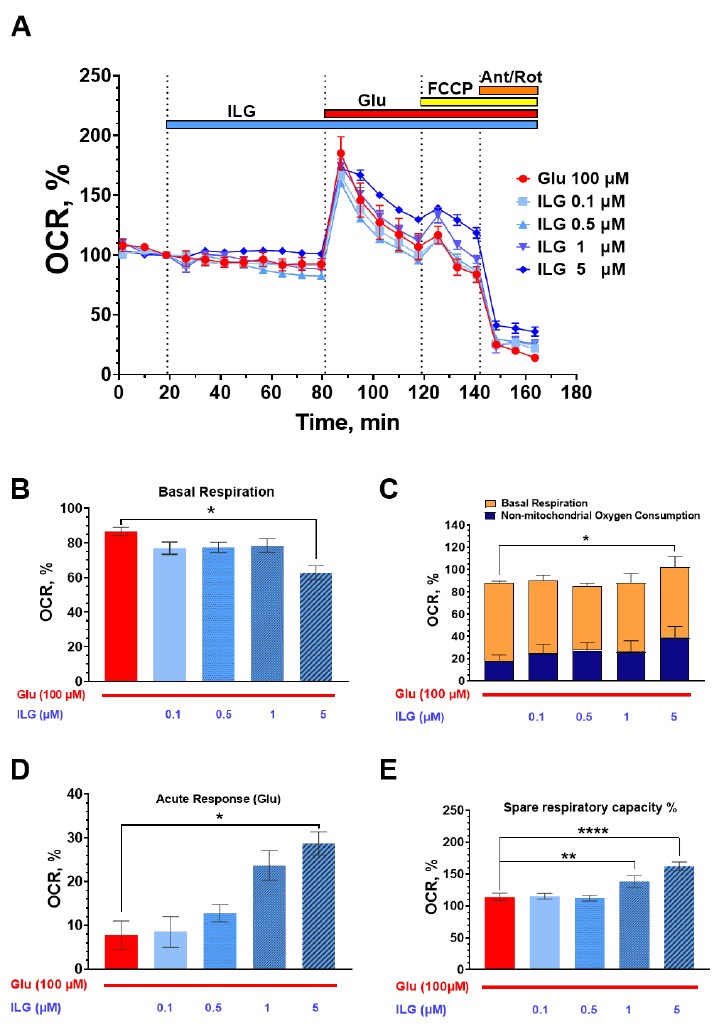
Figure 4. Effect of glutamate and ILG on the oxygen consumption rate (OCR) in primary neuroglial culture. ( A ) Cumulative curve of the effect of glutamate on OCR in the presence of ILG; ( B ) Basal mitochondrial respiration. ( C ) Oxygen uptake rate in ILG before glutamate injection (divided into mitochondrial and non-mitochondrial uptake rates). ( D ) Acute response to glutamate (corresponds to 118 min since experiment started). ( E ) Spare respiratory capacity of mitochondria. Three experiments were performed for each mito-stress test design. All data were normalized to the basal OCR of the cumulative curve (Mean ± SEM). * p < 0.05; ** p < 0.01; ***p < 0.001; ****p < 0.0001.